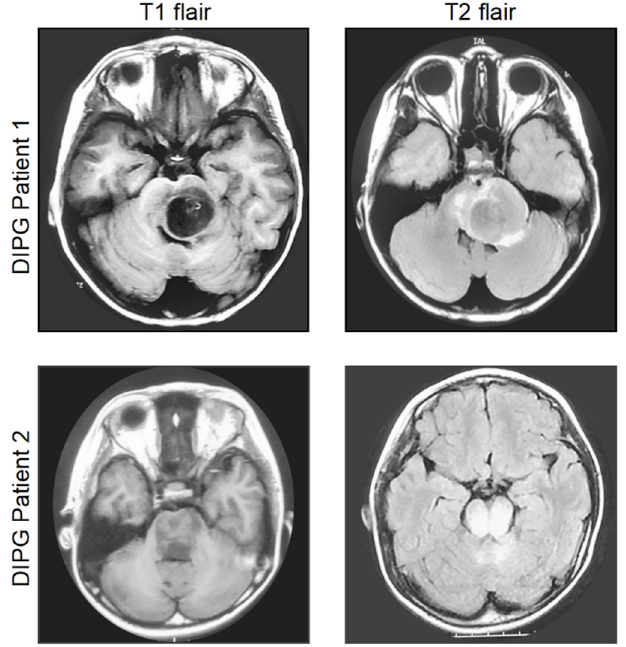
Figure 1. MRI images of two patients with radiographically classic DIPG. MRI image of two DIPG cases shows a space-occupying lesion in the pontine region, being relatively hypointense or isointense on T1-weighted images and hyperintense on T2-weighted images, when compared with a normal brain. DIPG Patient 1: 5 years, male; DIPG Patient 2: 7 years, female.